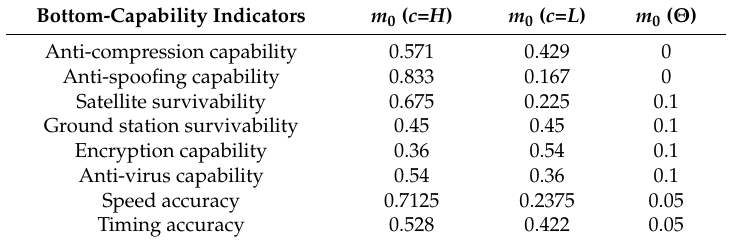
Table 3. The belief distribution of the degree of demand-satisfaction for bottom-capability indicators.